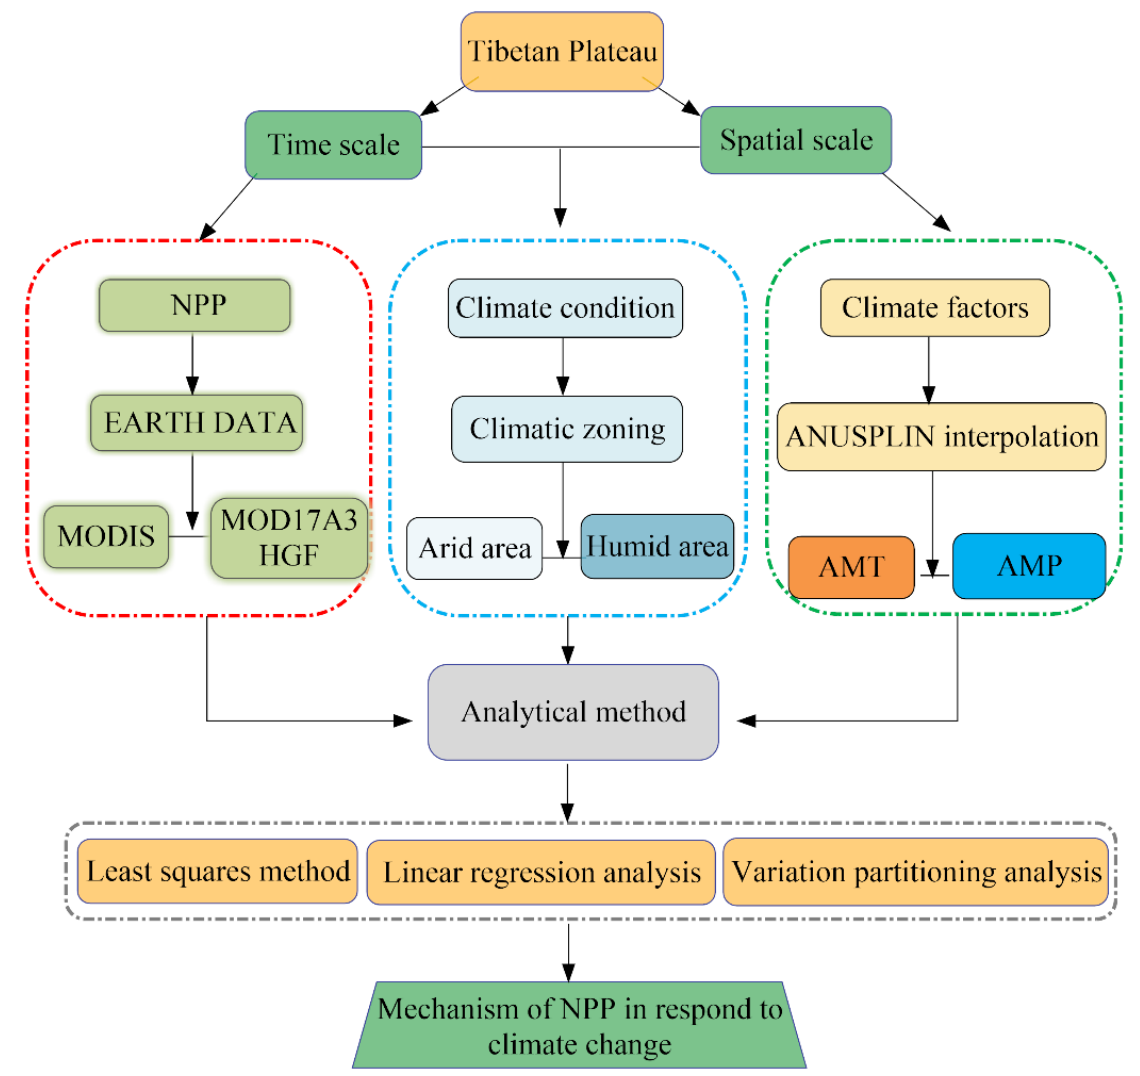
Figure 2. The technical route of this study. Table 1. The abbreviations used frequently in our study.